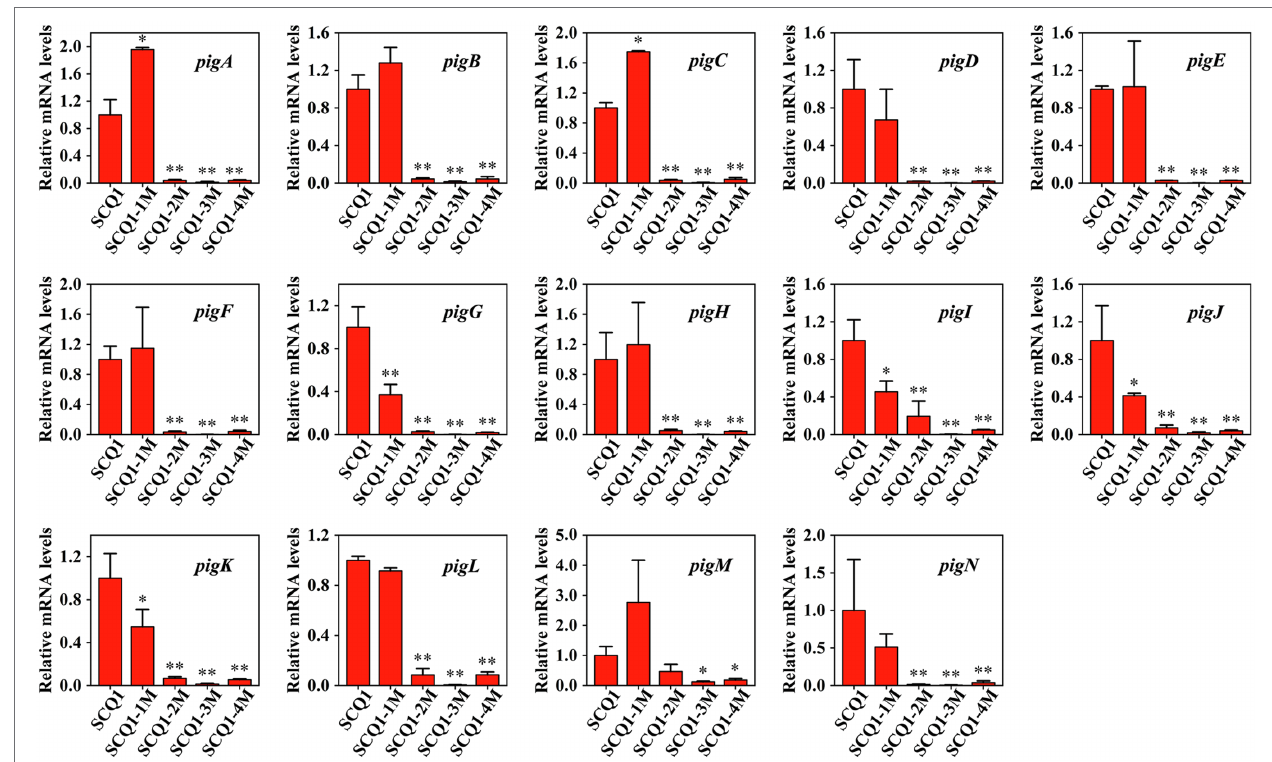
FIGURE 3 | The mRNA expression levels of pigA-pigN in the wild-type strain SCQ1 and the four spontaneous mutants by quantitative real-time RT-PCR (qRT-PCR) analysis. Relative mRNA levels are quantified using rpoB as internal control and the data are displayed as mean ± SE ( n = 3, * p < 0.05, ** p < 0.01).